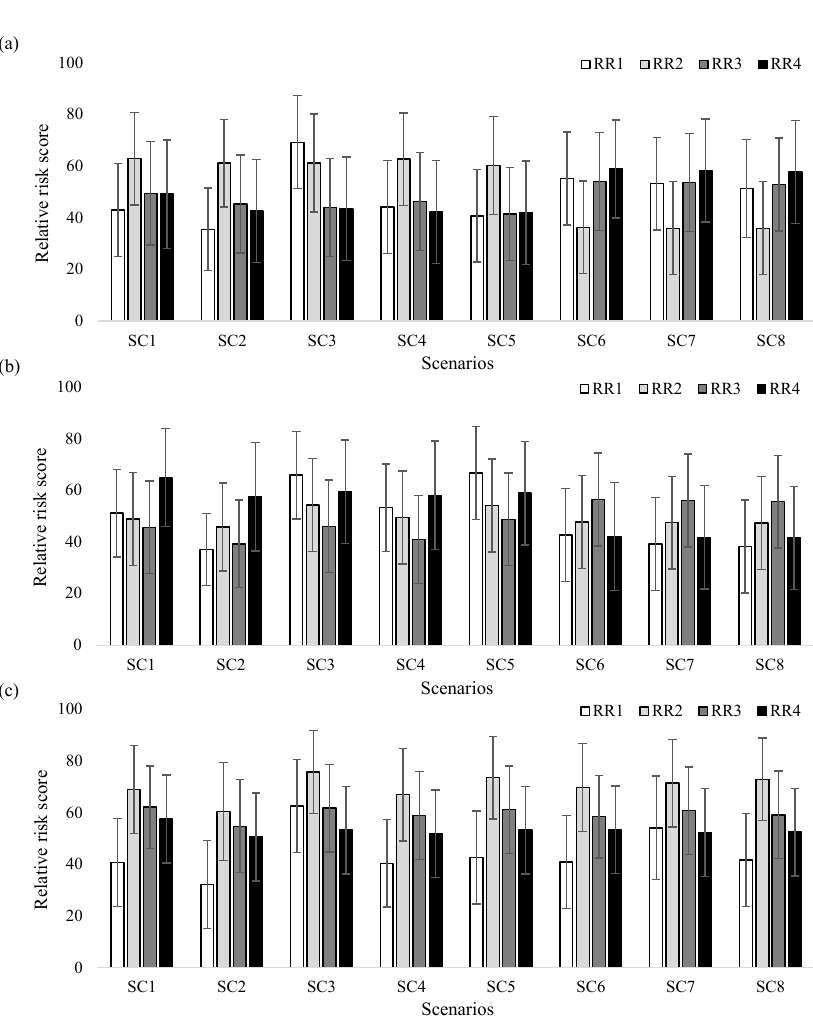
Figure 8. Senqu River mean relative risk scores (with SD) for wood for fuel (a) , marginal vegetation for livestock grazing (b) and fish for food (c) social endpoints for the four risk regions per scenario (SC) considered in the study.